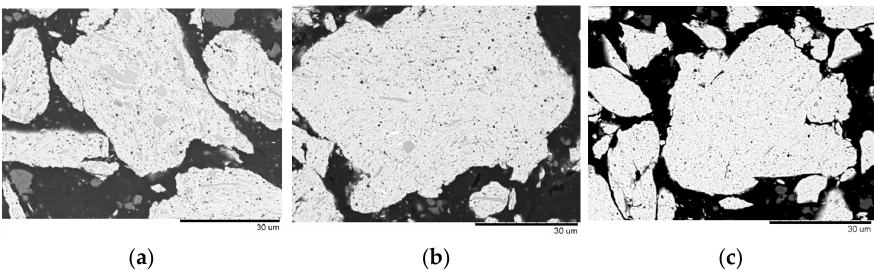
Figure 4. Microstructure (back-scattered electron (BSE) images) of Ti-C (carbon black)-3Cu powder agglomerates of the HEBM mixtures: milling time 3 min ( a ), 5 min ( b ) and 10 min ( c ). Reprinted from [39], Copyright (2021), with permission from Elsevier.